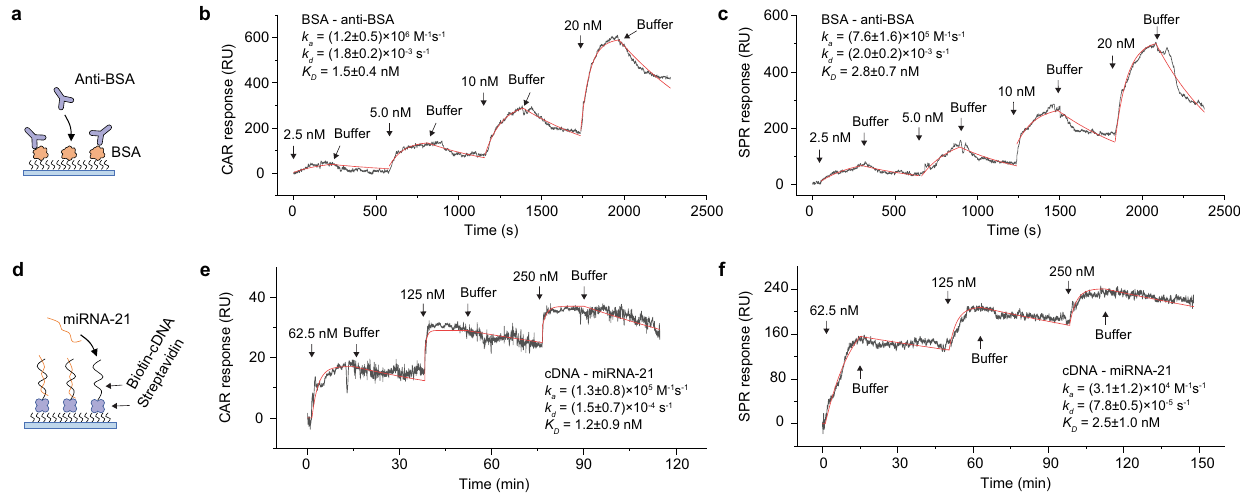
Fig. 2 Biomolecule detection. a Bovine serum albumin antibody (anti-BSA) binding to bovine serum albumin (BSA). BSA is immobilized on a glass or gold surface for CAR or SPR measurements. b Measuring anti-BSA — BSA binding kinetics with CAR. The incident angle was set at 61.1 degrees with a sensitivity of 25 RIU − 1 . Anti-BSA with different concentrations and buffer were sequentially fl owed over the BSA-coated surface. The CAR response (black curve) was fi tted to the fi rst order of kinetics (red curve). Note that 1 RU = 10 − 6 RIU = 1 pg/mm 2 of mass density. c Measuring anti-BSA — BSA-binding kinetics with SPR. The experimental conditions were the same as the CAR measurement. d MicroRNA-21 (miRNA-21) binding to complementary DNA (cDNA). The biotinylated cDNA was immobilized on a streptavidin-coated glass or gold surface via streptavidin-biotin conjugation. The miRNA-21 — cDNA binding was measured with CAR ( e ) and SPR ( f ), and the curves (black) were fi tted to the fi rst-order kinetics (red curves). The CAR incident angle was set at 61.4 degrees with a sensitivity of 50 RIU − 1